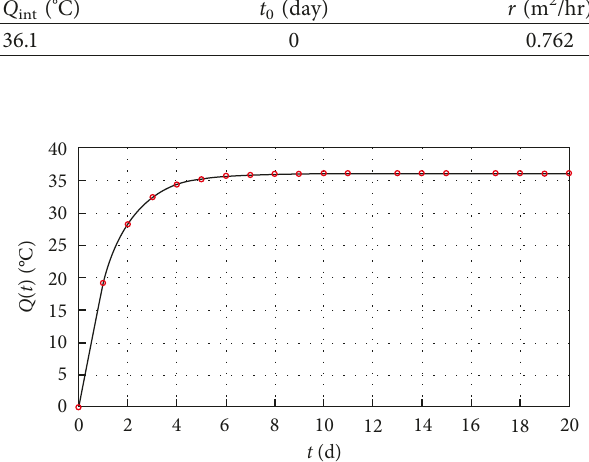
Figure 6: Model of adiabatic temperature rise for the